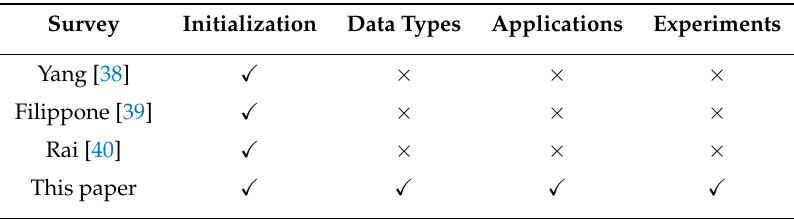
Figure 1. A simple taxonomy of variants of k-means algorithm. Table 2. Comparison with existing